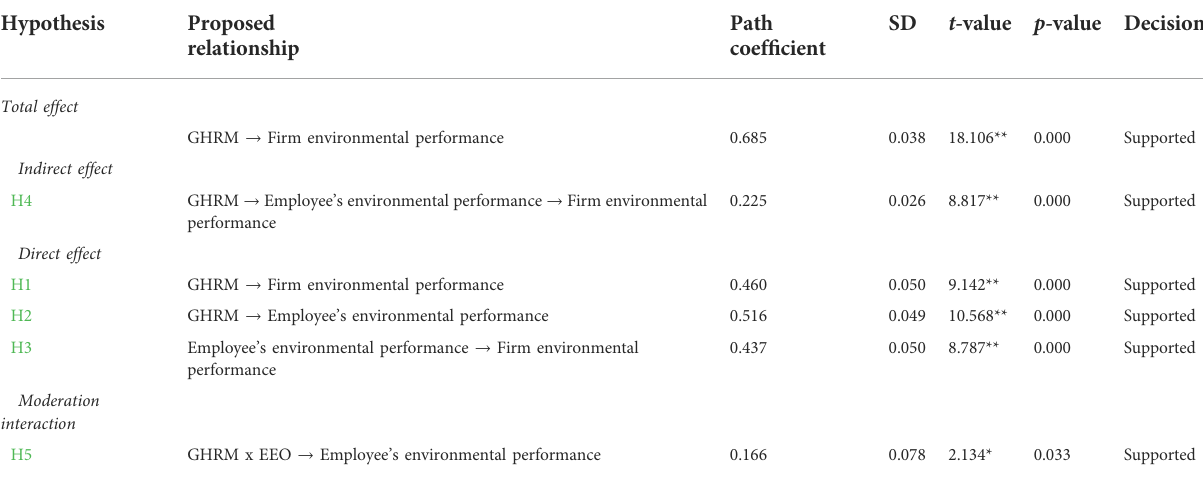
TABLE 4 Hypotheses testing and strength of the model.